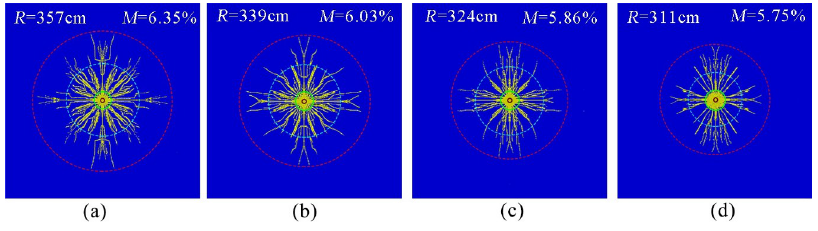
Fig 7. Crack distribution at different elastic moduli. (a)Elastic modulus 6.5 MPa.(b)Elastic modulus 4.5 MPa.(c) Elastic modulus 2.5 MPa (d)Elastic modulus 0.5 MPa.